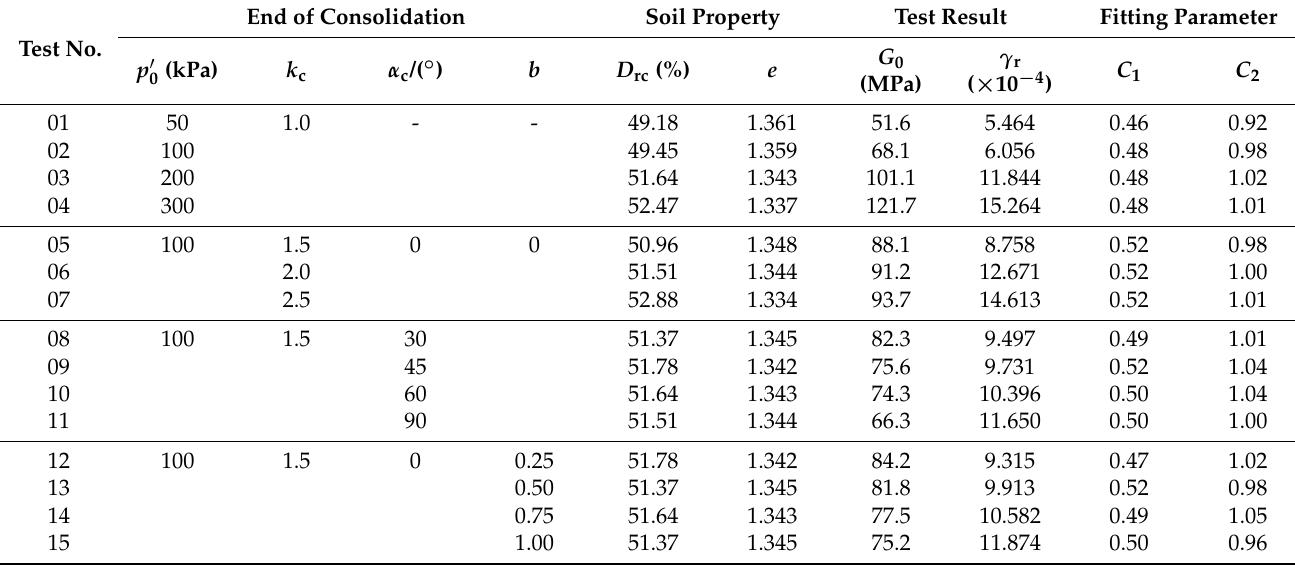
Table 3. Scheme of multi-stage strain-controlled undrained cyclic shear